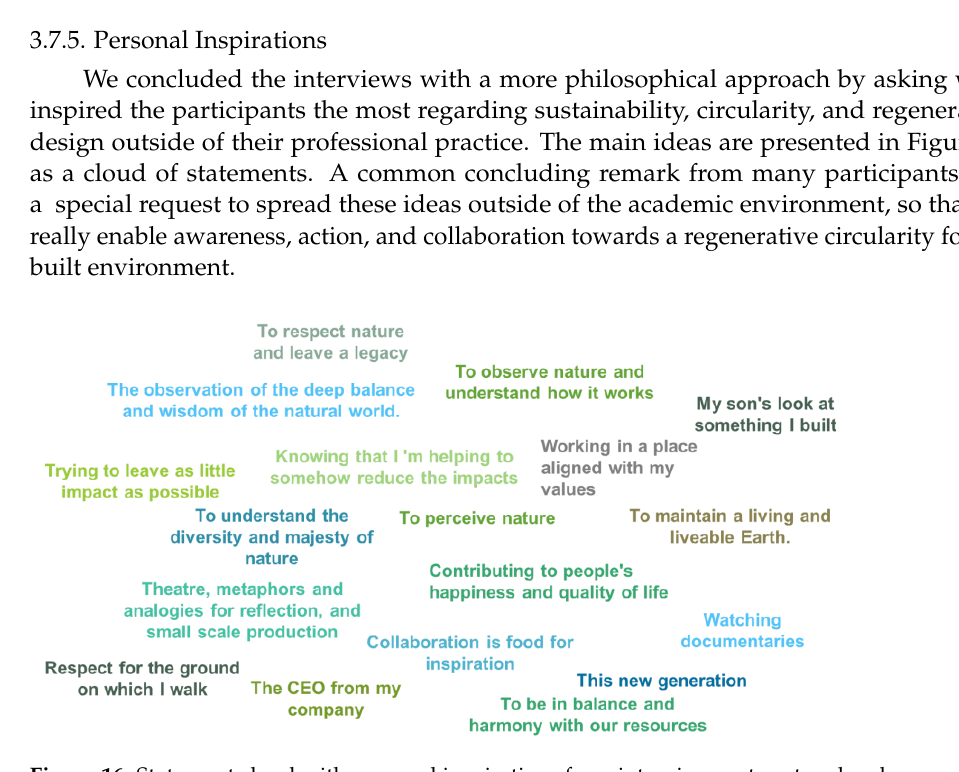
Figure 16. Statement cloud with personal inspirations from interviewees to act and embrace sus- tainability